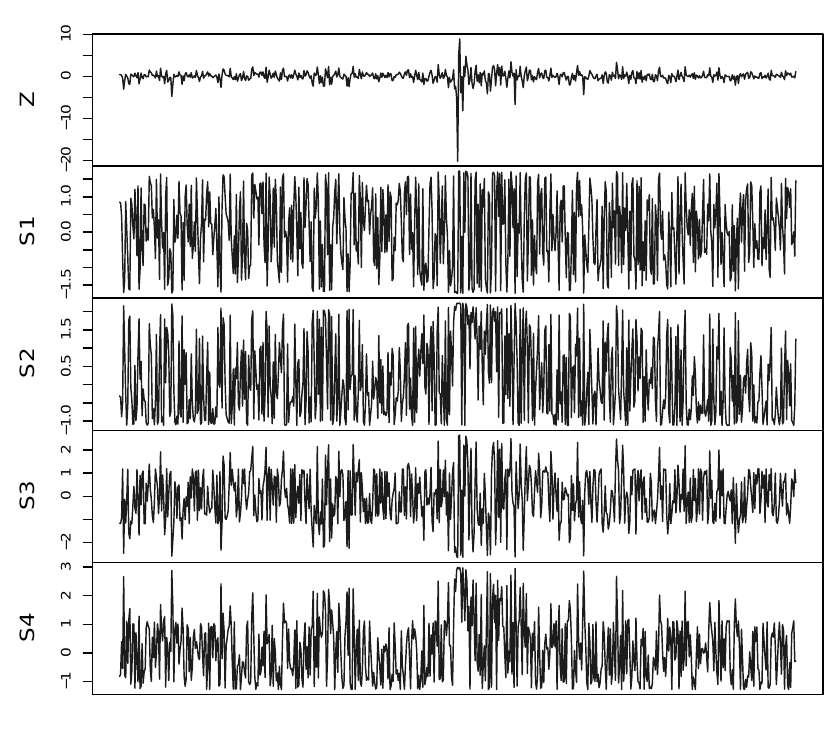
Figure 1. LP-transformed S&P 500 daily stock returns between October 1986 and October 1988. This is just a small part of the full time series from 2 January 1963–31 December 2009 (cf. Section